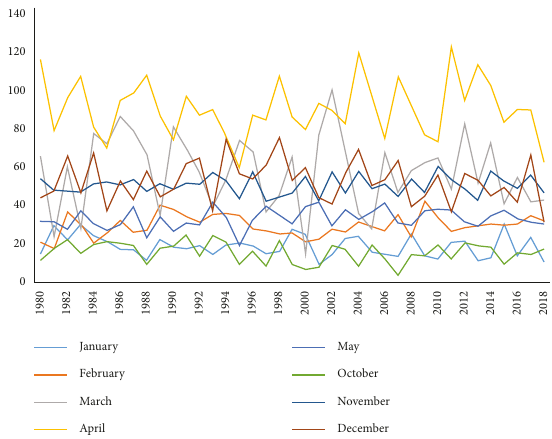
Figure 3: Monthly demand for middle rice. Figure 4: Monthly demand for middle